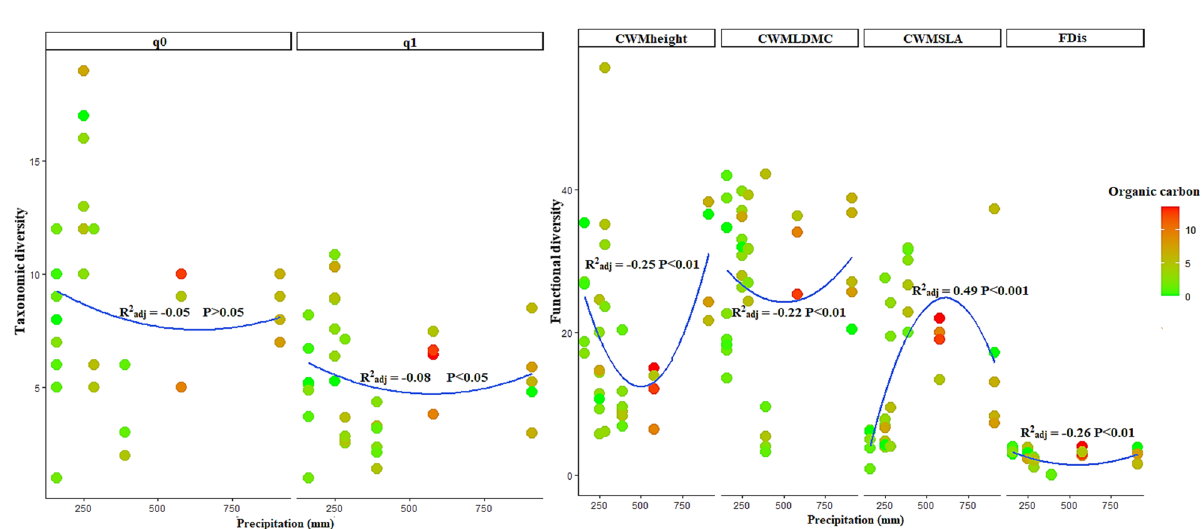
Figure 2. Variation in taxonomic (q 0 and q 1 in left panels) and functional (CWMheight, CWMLDMC, CWMSLA and FDis in right panels) diversity in rocky outcrops across precipitation and organic carbon